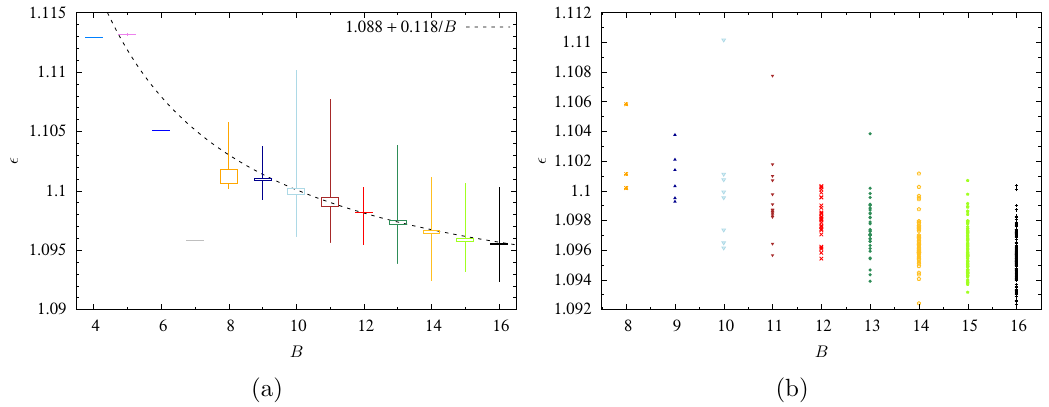
Figure 12. Energy normalized by the energy bound and divided by the baryon number B . That is (cid:15) of eq. (2.40). (a) The mean and median as a box with the lines representing the spread. (b) Scatter plot of the energies.